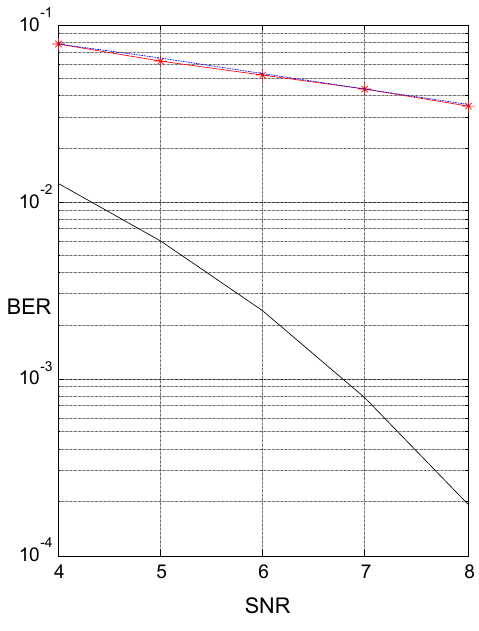
Figure 3. BER curves for a single-correlator receiver in the presence of AWGN and fading: theoretical (blue), simulation (red) for fading, and theory for noise only (black).